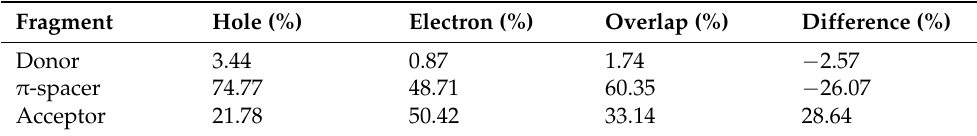
Table 8. Fragment contribution to electron–hole overlap in O5 .